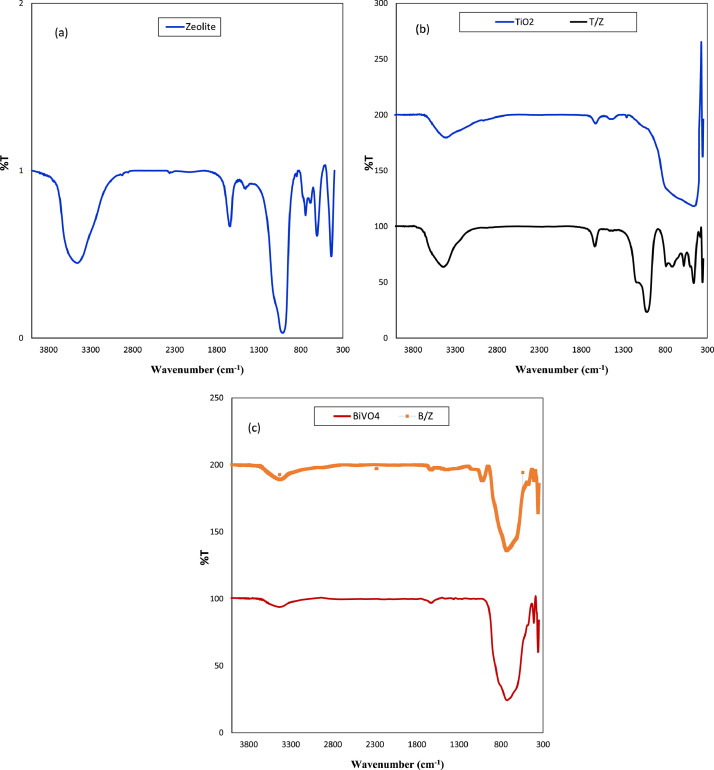
The FT-IR pattern of the studied materials of a) Zeolite b) TiO2/Zeolite, TiO2 c) BiVO4/Zeolite, BiVO4.